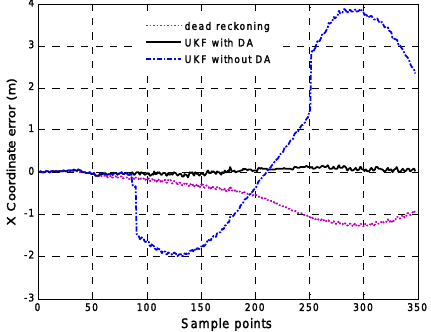
Fig. 8. Localization X Coordinate Error